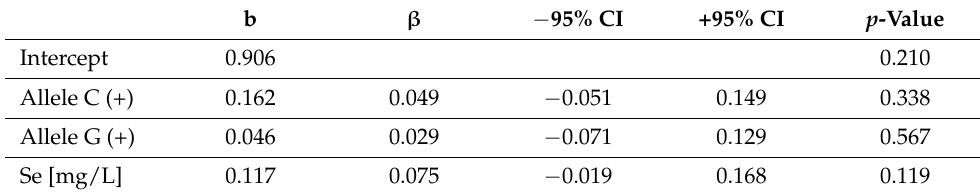
Table 7. Dependent variable: the BDI score (without moderation).